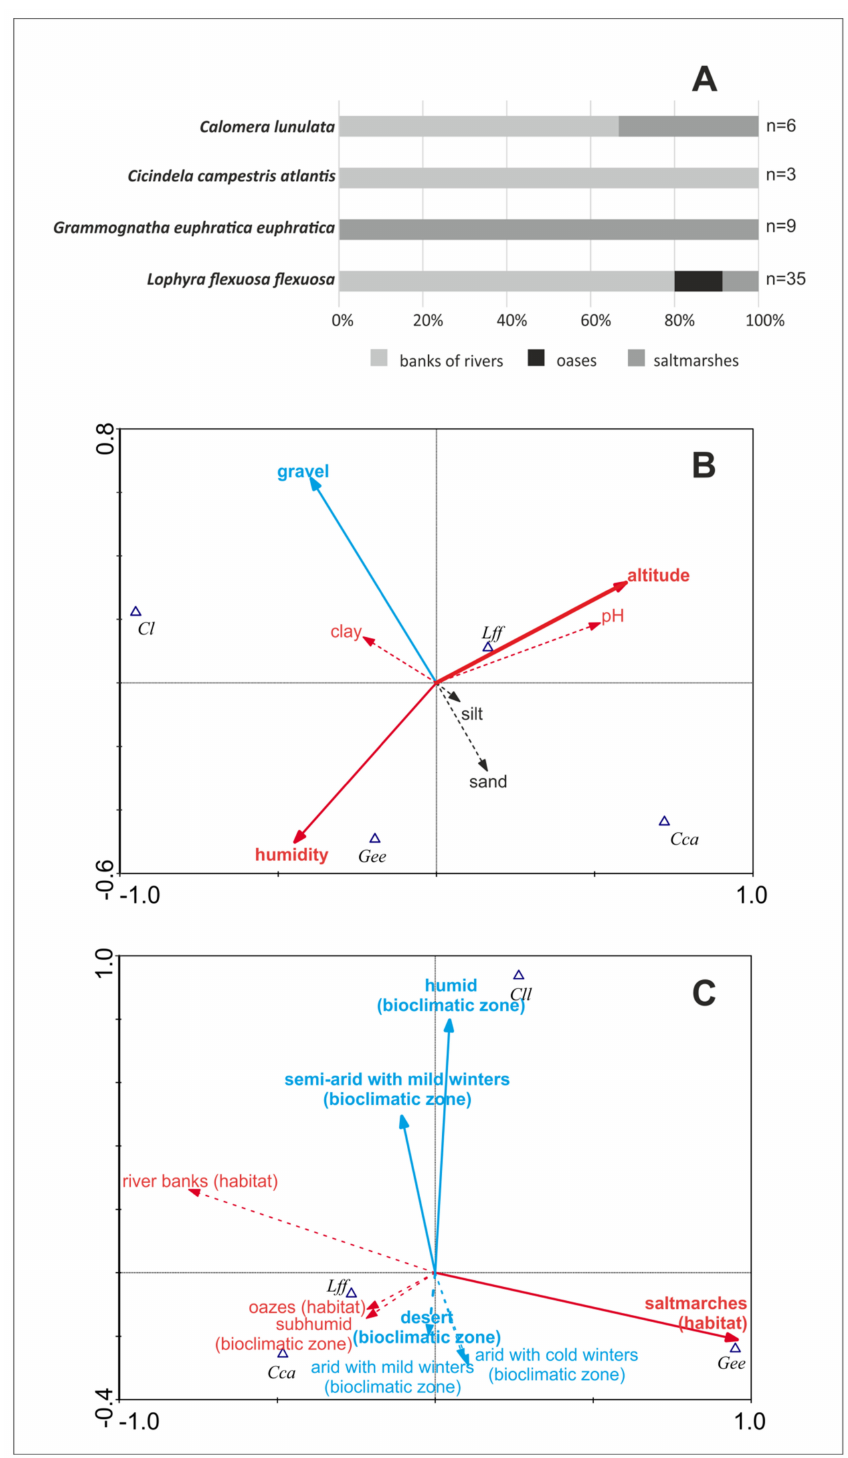
Figure 2. Habitat preferences of the studied tiger beetles in Tunisia. ( A ) Macrohabitat preferences. ( B ) Results of canonical component analysis (CCA) with microhabitat parameters measured as environmental variables. ( C ) Results of canonical component analysis with macrohabitat types and bioclimatic zones as environmental variables. Solid arrows ( B , C ) indicate environmental variables significantly explaining species variance; dashed arrows indicate insignificant environmental variables. Red arrows indicate variables correlated with axis (Ax) 1; blue arrows indicate variables correlated with Ax 2, black arrows—variables not correlated with Ax 1 or Ax 2. Gee: Grammognatha euphratica euphratica , Cl: Calomera lunulata , Cca: Cicindela campestris atlantis , L ff : Lophyra flexuosa